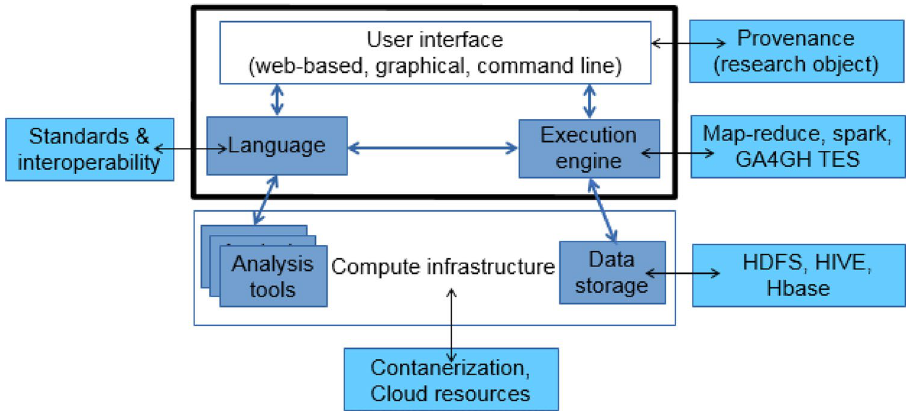
Figure 1. A WfMS is middleware between the analyst and the computational environment. It encompasses the workflow language specifications to interconnect the analysis executables, and the execution engine to dispatch tasks and manage dependencies on the compute